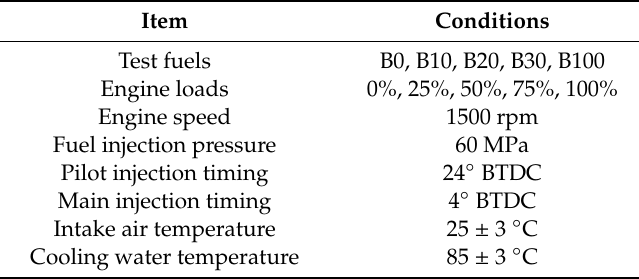
Table 3. Experimental and operating